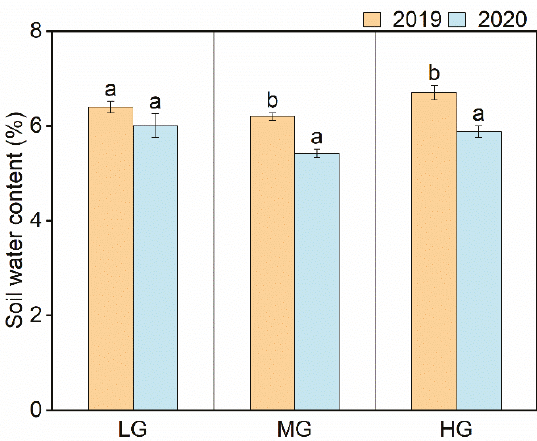
Figure 7. The soil water contents under the different grazing intensities in the two contrasting years. Mean ± SE. Different letters indicate significant differences ( p < 0.05) between the two years under the same grazing intensity.